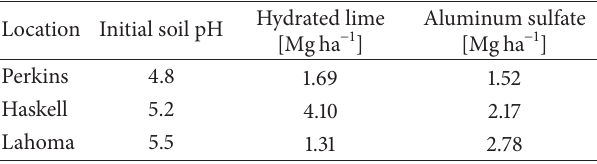
), effective cation exchange capacity (ECEC), and aluminum saturation KCl